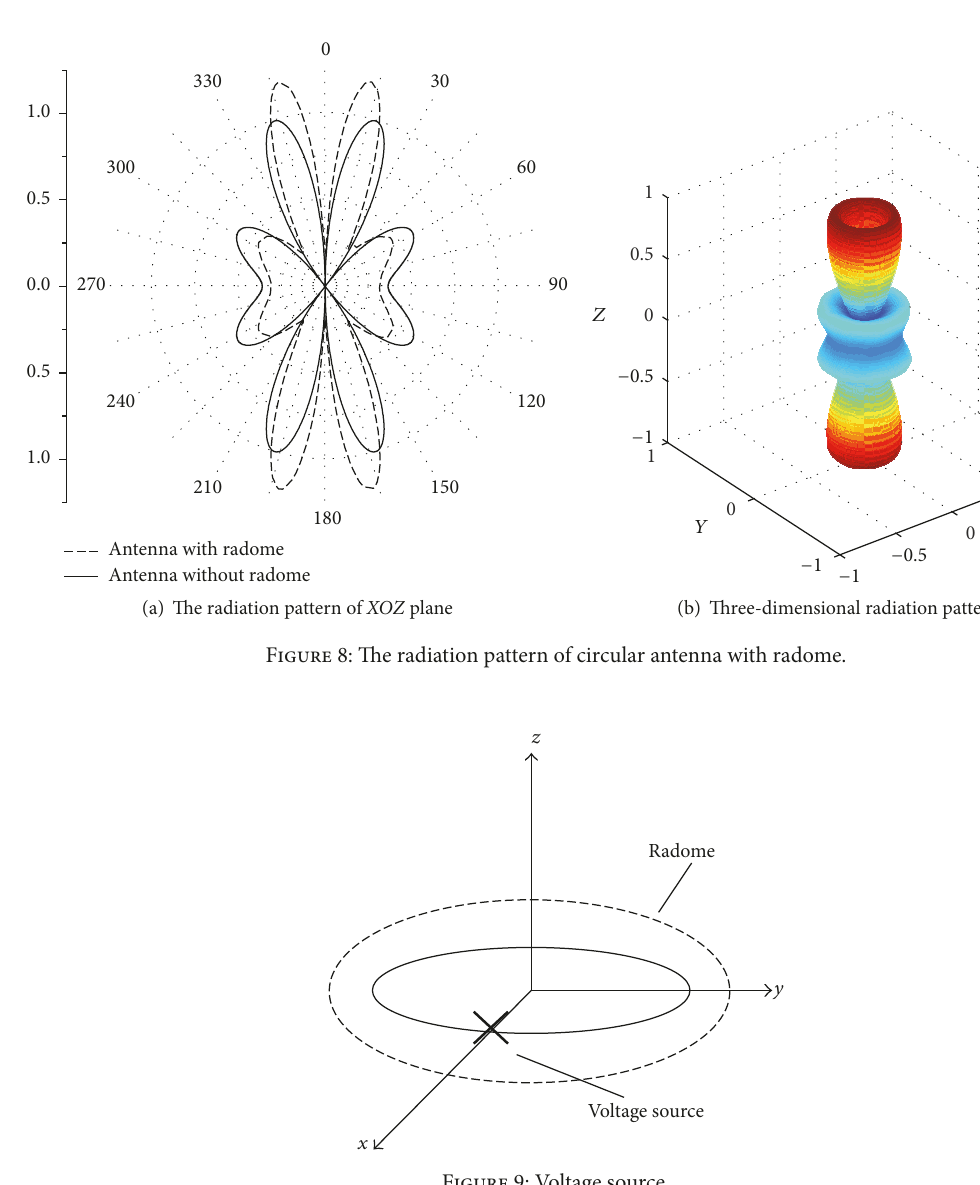
Figure 7: Sectional view grid.